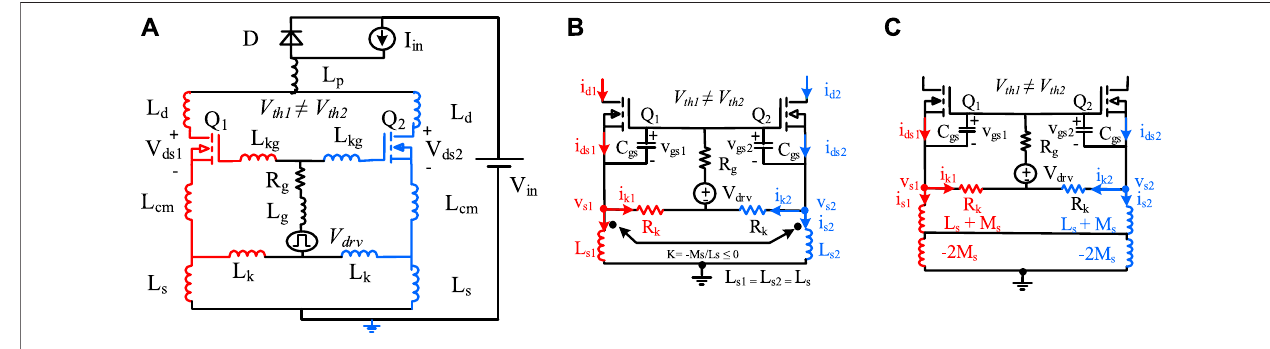
FIGURE12|(A) Doublepulsetest(DPT)circuitofParallel-connectedMOSFETswithdifferent V th includingcircuitparasitic (B) Circuitdiagramofparallel-connected SiC MOSFETs with additional components to balance the current distribution (C) Equivalent circuit diagram (Mao et al., 2017a) (Note: R k (cid:2) drive source resistor, M s (cid:2) mutual inductance, L s (cid:2) self-inductance, L s1 /L s2 (cid:2) power source inductors that are negatively coupled).